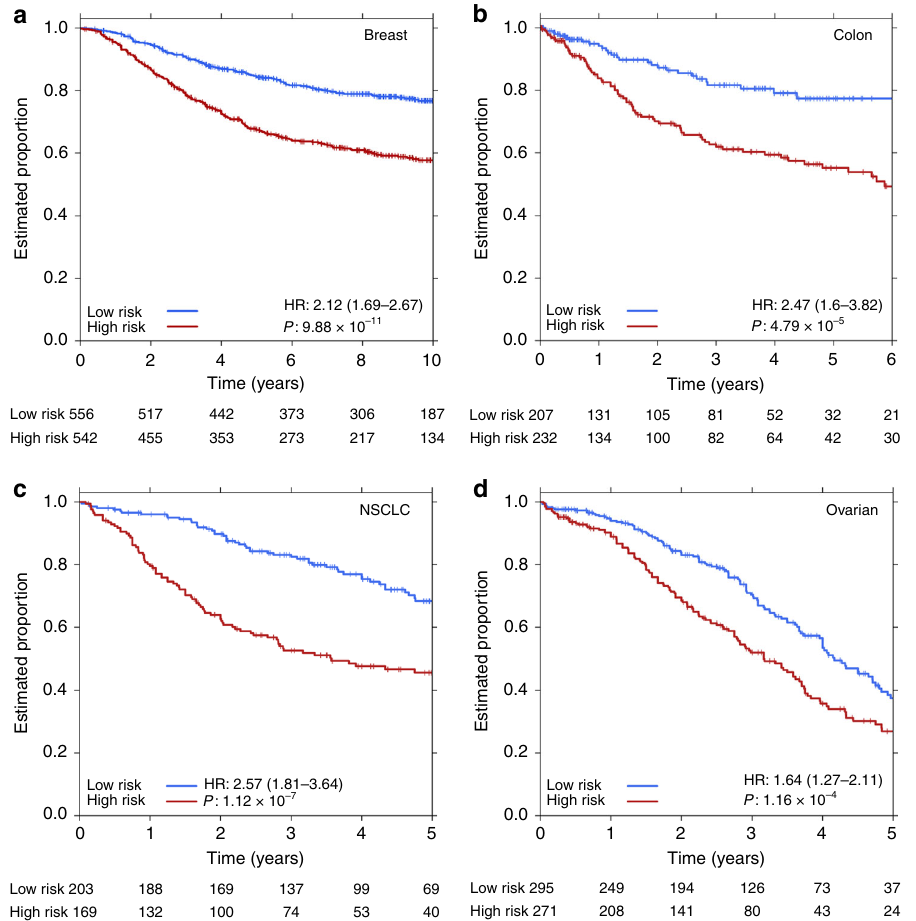
Fig. 3 Multi-subnetwork biomarkers for multiple cancer types. a – d Kaplan – Meier survival plots using Model N over the entire validation cohort with subnetwork selection performed through Cox model using generalized linear models ( L1 -regularization) on the training cohort. Final model resulted in 23/ 50, 5/75, 23/25, and 23/50 subnetworks for breast, colon, NSCLC and ovarian cancers, respectively (Supplementary Tables 10 – 13). P values were estimated using